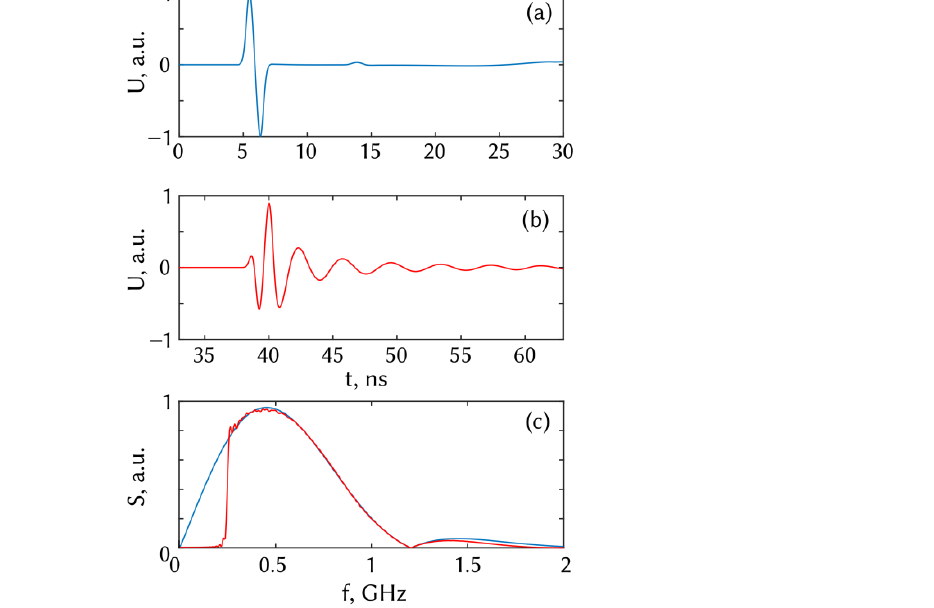
Figure 10. “Gigantic” coaxial line during its testing in KROT facility room.